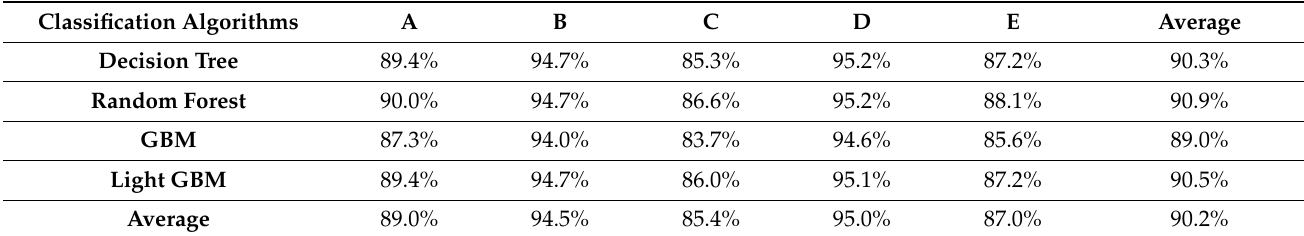
Table 7. The average of weight classification accuracy of the developed ML-based analysis model. Classification